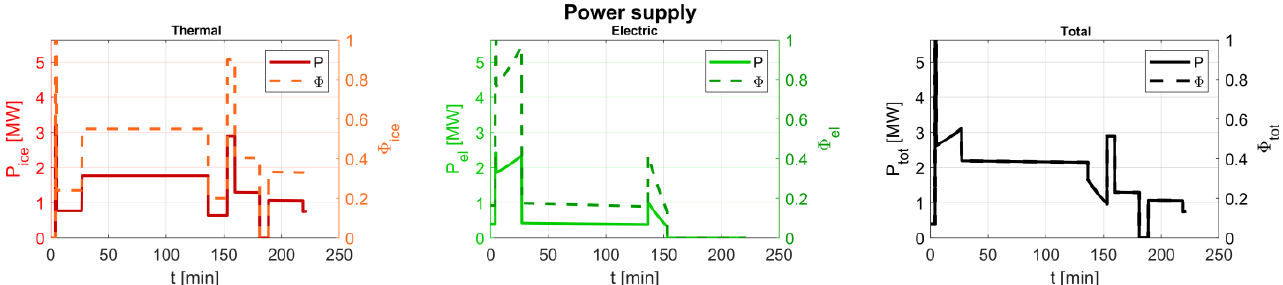
Figure 9. Mission simulation outcomes: trajectory (left), slope angle (centre), lift – drag ratio (right).